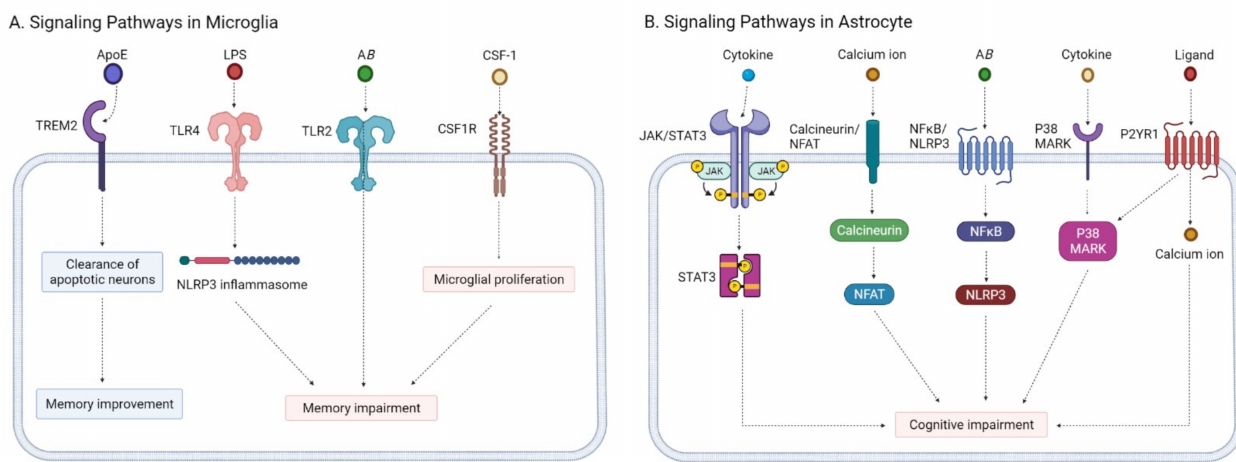
Figure 1. Signaling pathways of microglia modulators and astrocyte modulators. ( A ) Signaling pathways in microglia; ( B ) signaling pathways in astrocytes. Created with BioRender.com. * TREM2—triggering the receptor expressed on myeloid cells 2, TLR—Toll-like receptor, CSF1R—colony-stimulating factor-1 receptor, JAK—Janus kinase, STAT3—signal transducer and activator of transcription 3, NFAT—nuclear factor of activated T cells, NF κ B—nuclear factor-kB, NLRP3—nod-like receptor family pyrin domain containing 3, MAPK—mitogen-activated protein kinase, P2Y1R—P2Y1